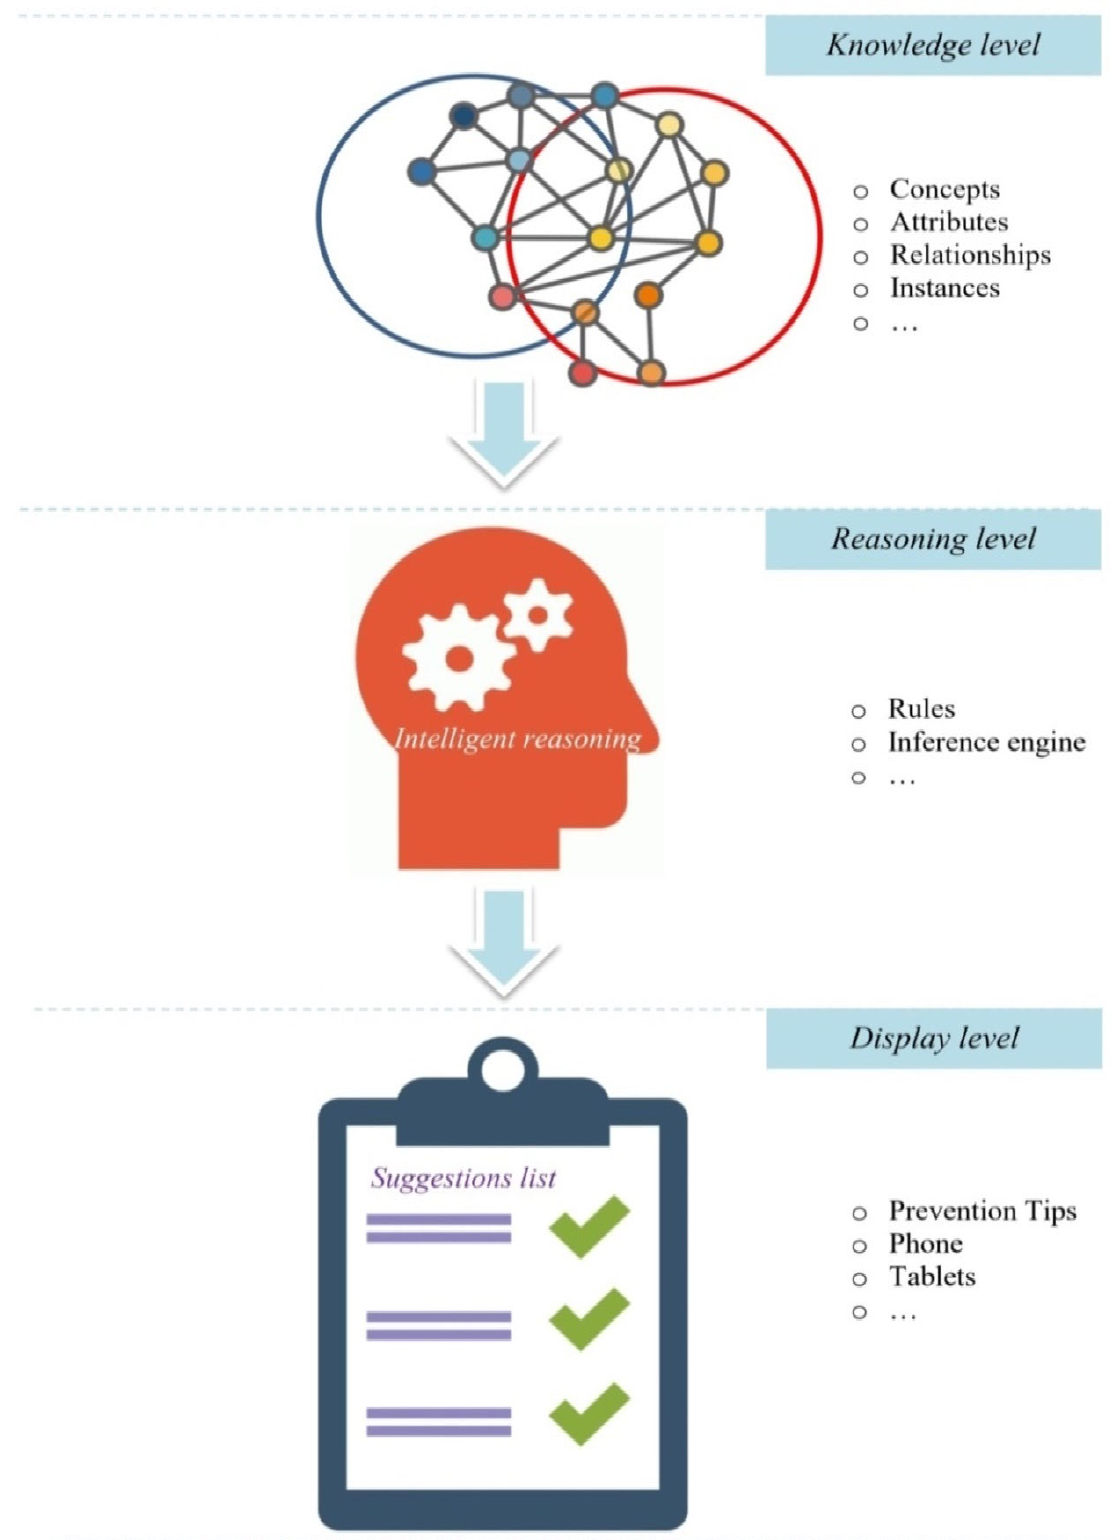
Figure 1. Architecture of the proposed solution.